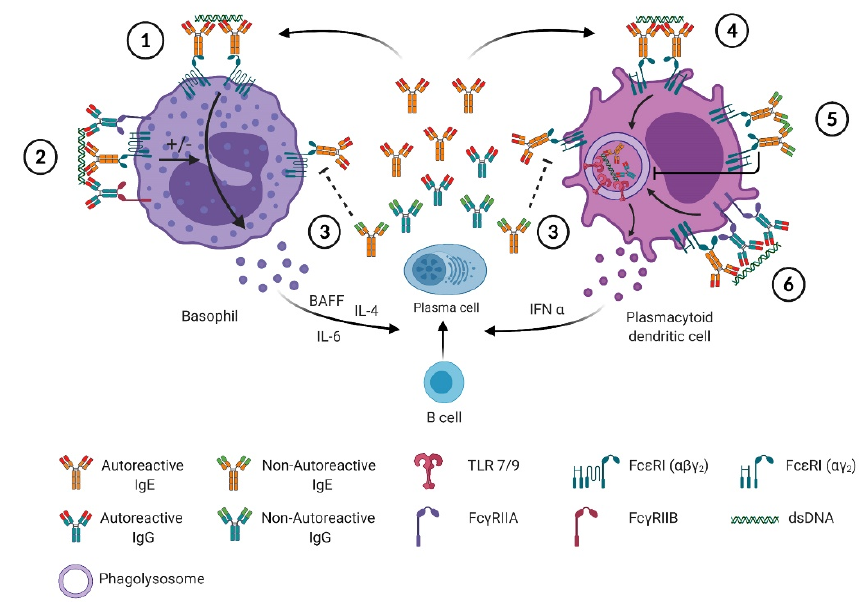
Figure 1. Autoreactive and non-autoreactive IgE e ff ects on basophils and pDC in SLE. 1: The binding of the autoreactive IgE to dsDNA induces the crosslinking of the high a ffi nity receptor for IgE (Fc ε RI) at the surface of basophils, which can lead to their degranulation and the secretion of lipid mediators and cytokines, such as: IL-4, IL-6 and BAFF. The secreted cytokines promote plasma cells di ff erentiation and amplifies the secretion of autoreactive and non-autoreactive IgE / IgG. 2: In immune complexes, IgE and IgG autoreactive antibodies, together with the autoantigens, can aggregate both activating